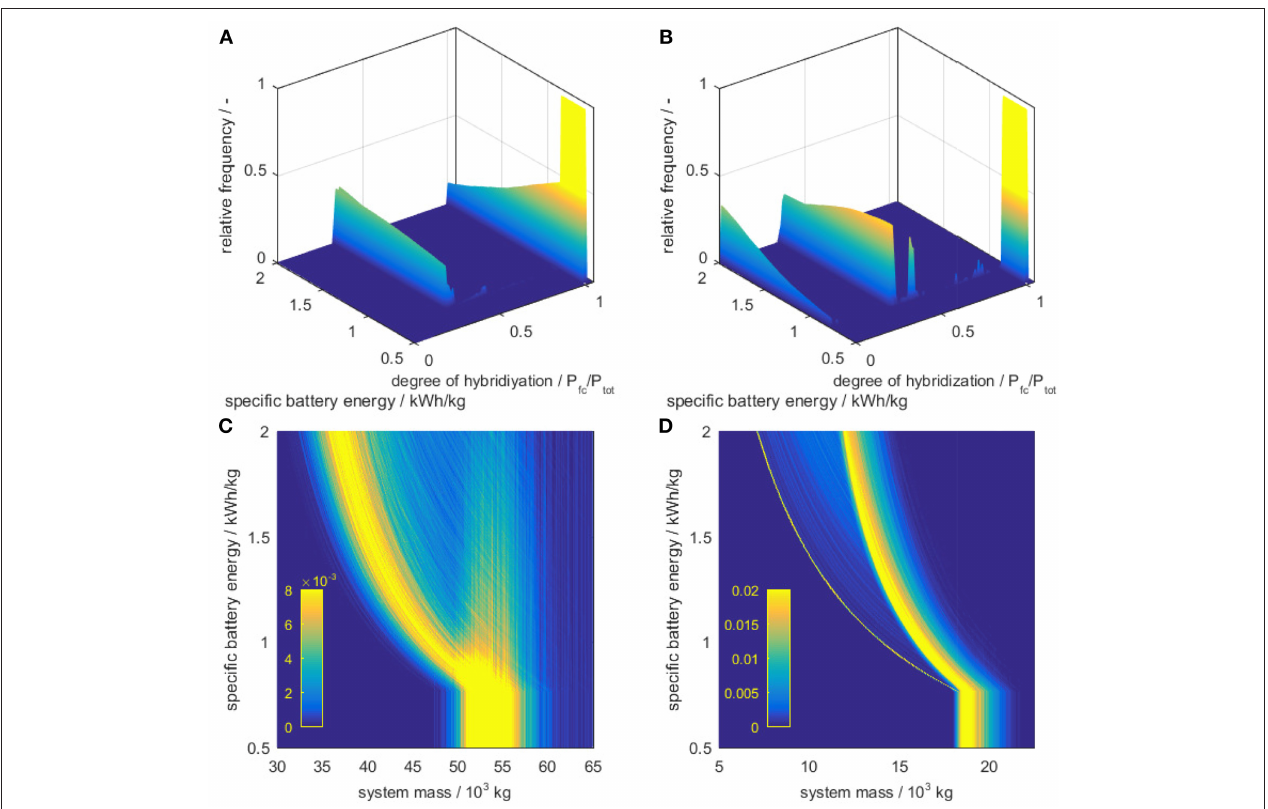
FIGURE 7 | Parameter study of the specific energy of the battery. Left: A320, right B772. (A,B) Show the optimum degree of hybridization; (C,D) show the minimized mass of the energy system, where the color code indicates the relative frequency. specific energy, the peak of the fuel cell-only system declines and the hybrid system peak dominates.